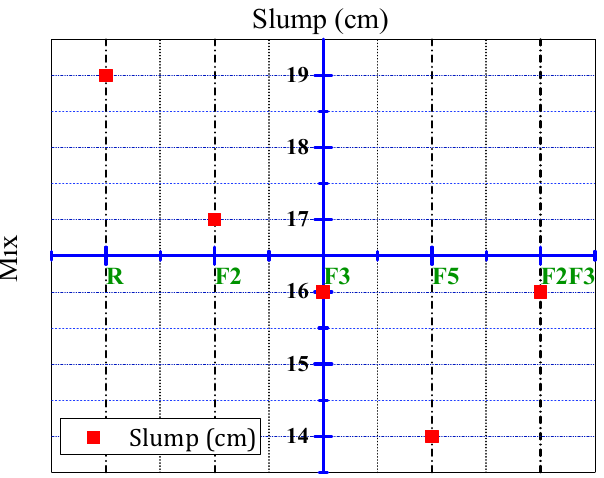
Figure 4. Result of slump test.